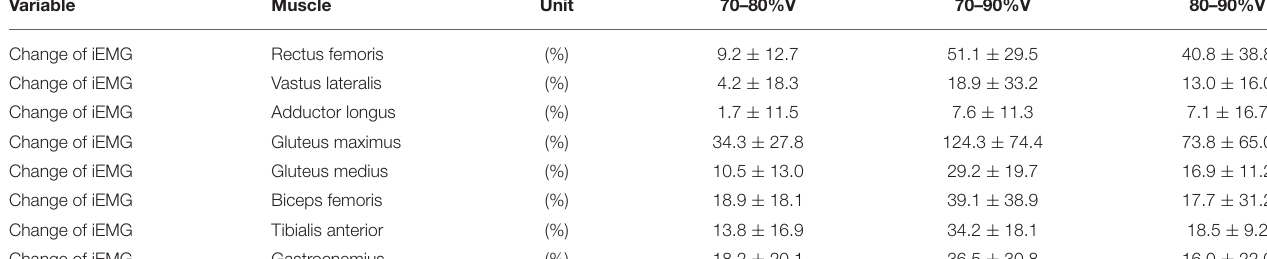
TABLE 4 | Magnitudes of changes (%) in iEMG from 70%V and from 80%V. Variable